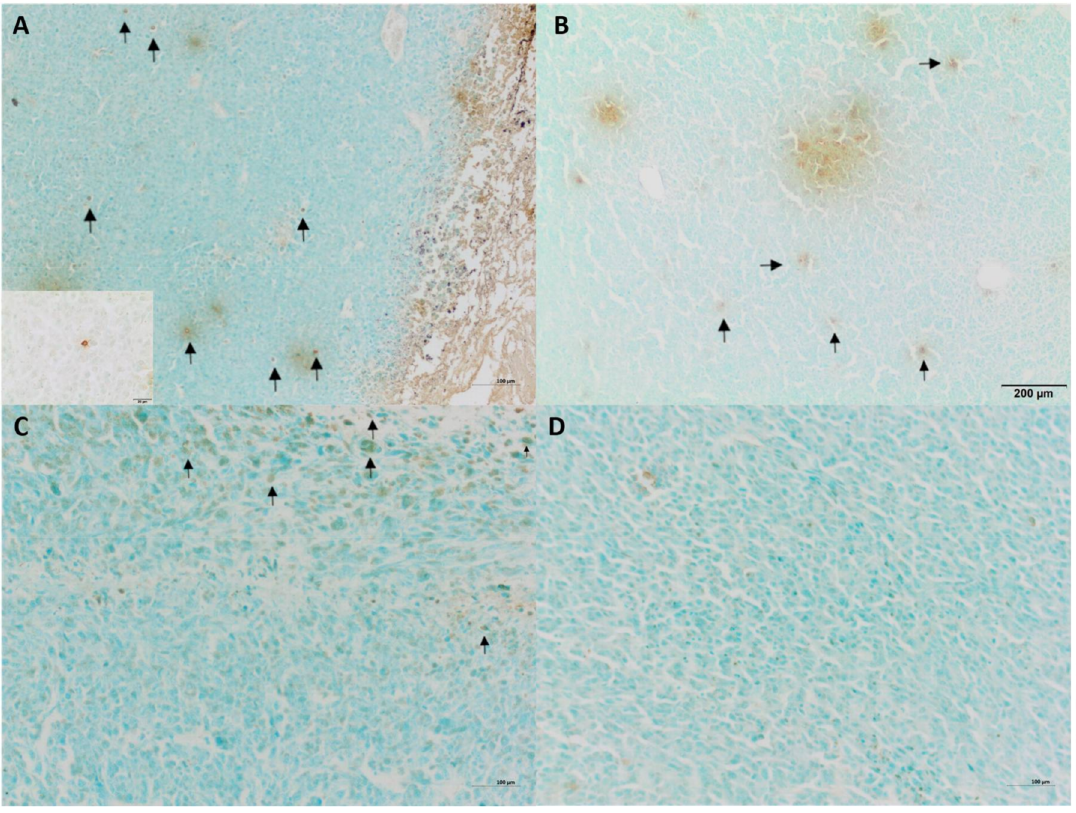
Figure 10. TUNEL staining of tumors treated with Au-GSH-Dox ( A , B ) and Dox alone ( C , D ) in tumor core and the periphery of tumors. Arrows indicate apoptotic bodies. Bar graph 100 µ m ( A , C , D ) and 200 µ m ( B ). Insert 20 µ m.